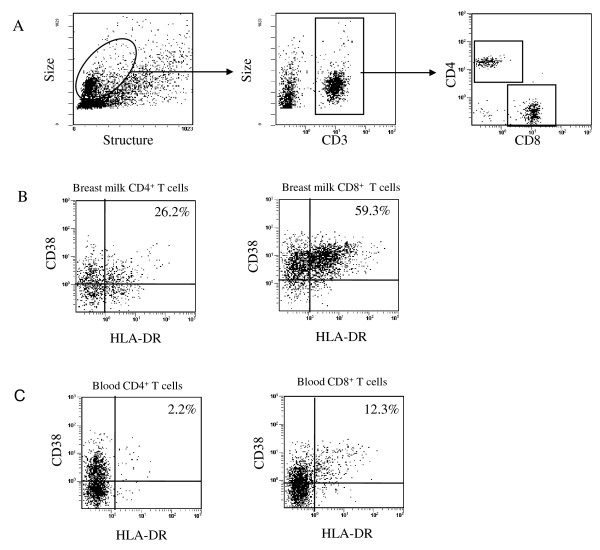
Representative dot plots from breast milk and blood samples of an HIV-1-infected woman (no 8) (A) Gating strategy to explore breast milk CD4+ T cells and CD8+ T cells. (B) Analysis of CD38 and HLA-DR cell-surface expression on breast milk CD4+ T cells (left) and CD8+ T cells (right). (C) CD38 and HLA-DR cell surface expression on blood CD4+ T cells (left) and CD8+ T cells (right) using the same gating strategy. The percentage of cells positive for both HLA-DR and CD38 staining is given in the upper quadrant of each dot plot.